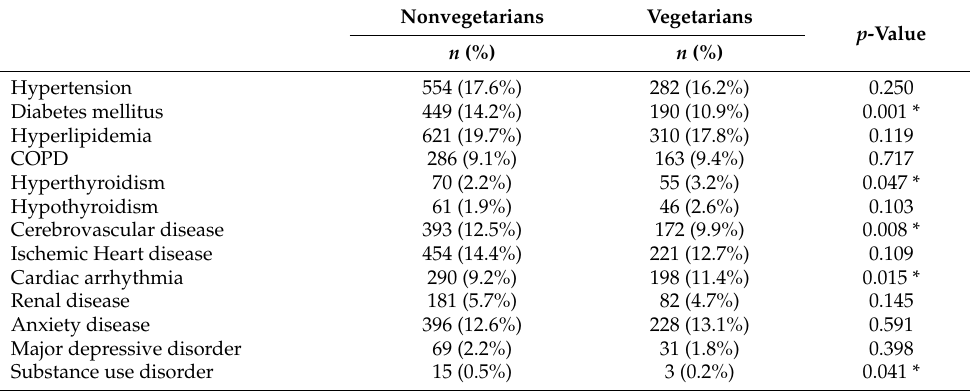
Table 2. Baseline medical comorbidity of vegetarians and